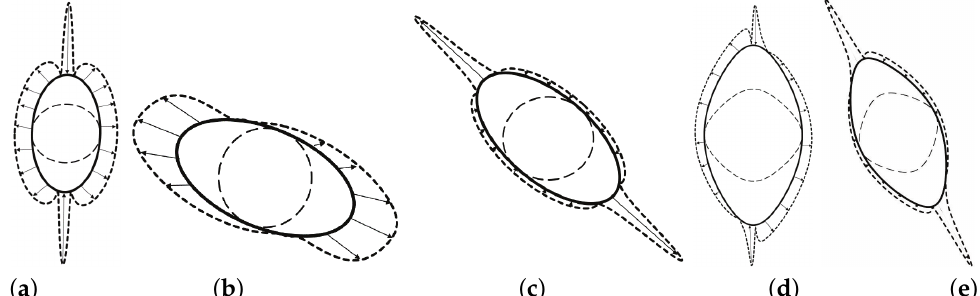
Figure 19. Stress distribution around cutout for graphite/epoxy plates in an optimal condition: ( a ) uniaxial tensile loading ( w = 0, C.F. = 1.685), elliptical ( c = 2, θ 1 = 88.6 ◦ , θ 2 = 0 ◦ , θ 3 = 178.6 ◦ ); ( b ) equibiaxial loading ( w = 0, C.F. = 3.397), elliptical ( c = 2, θ 2 = 0 ◦ , θ 3 = 69.3 ◦ ); ( c ) shear loading ( w = 0, C.F. = 1.924), elliptical ( c = 2, θ 2 = 45 ◦ , θ 3 = 45.3 ◦ ); ( d ) uniaxial tensile loading ( w = 0.05, C.F. = 1.826), rectangular ( c = 2, θ 1 = 77.5 ◦ , θ 2 = 0 ◦ , θ 3 = 180 ◦ ); and ( e ) shear loading ( w = 0.05, C.F. = 1.826), rectangular ( c = 2, θ 2 = 43 ◦ , θ 3 = 26.4 ◦